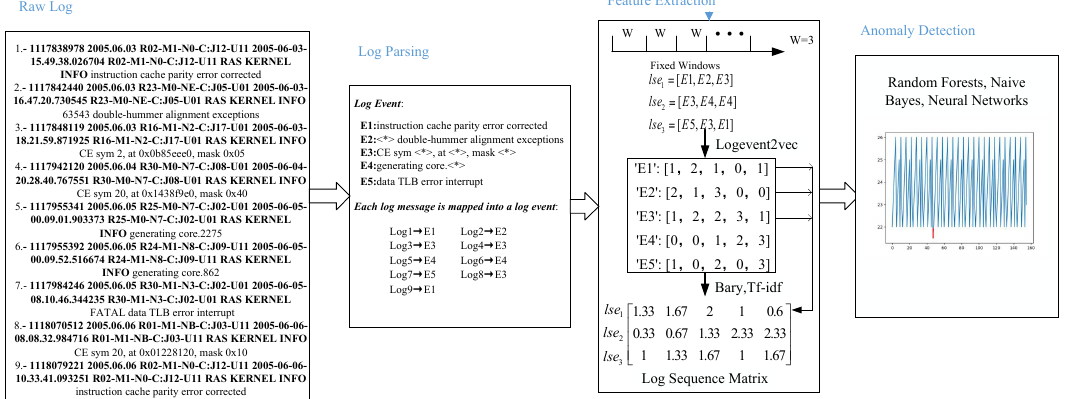
Figure 2. Overview of Log Event to vector based log anomaly